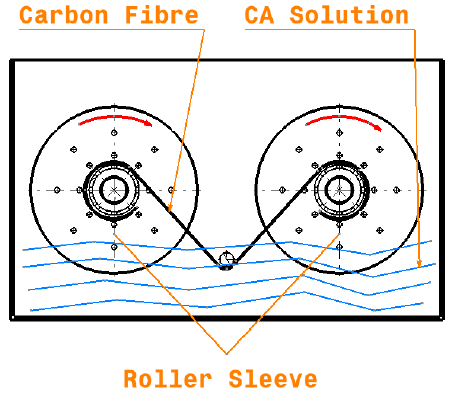
Figure 4. Fibre immersion bath.